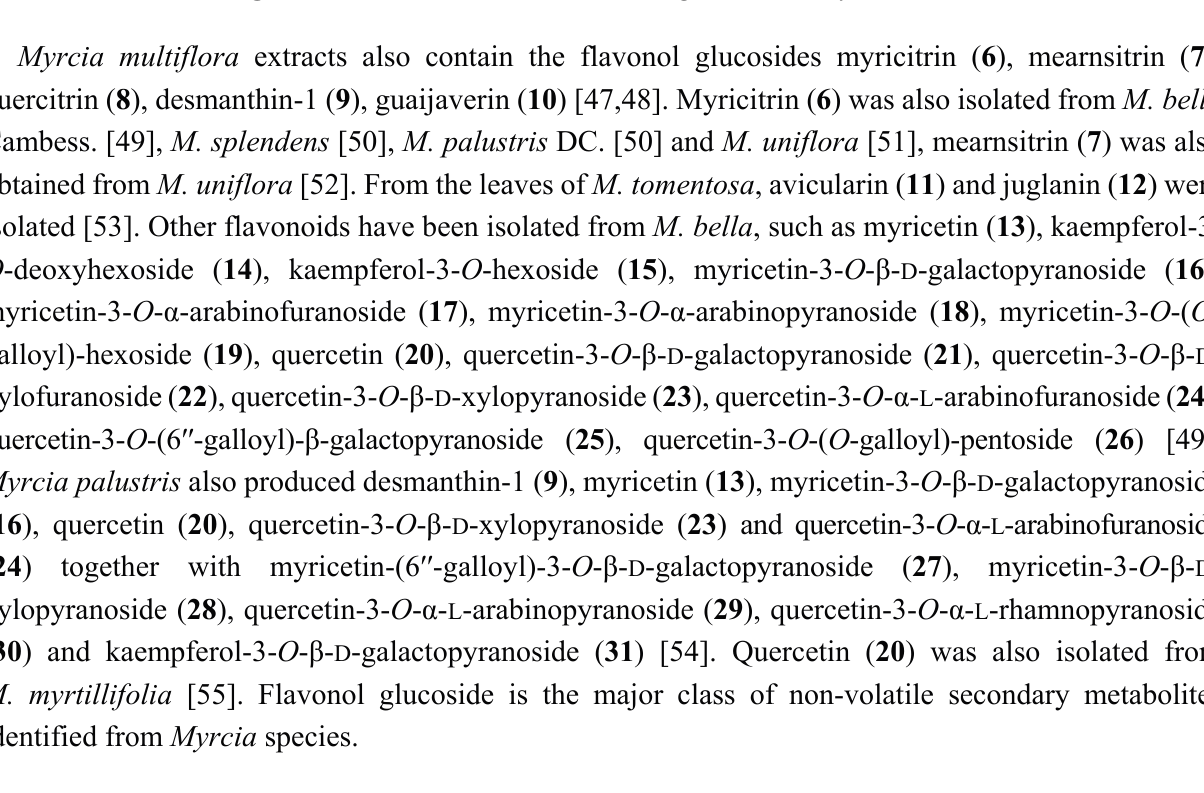
Figure 1. Structures of the flavanone glucosides